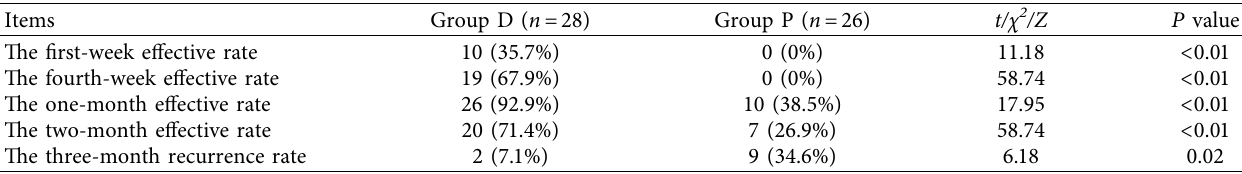
Figure 2: An example of PHN patient with MPS. (a) The MTP in the external oblique muscle of the abdomen. (b) The arrow shows the dry needle body. (c) The original MTP location after DN treatment. Table 2: Comparison of the therapeutic